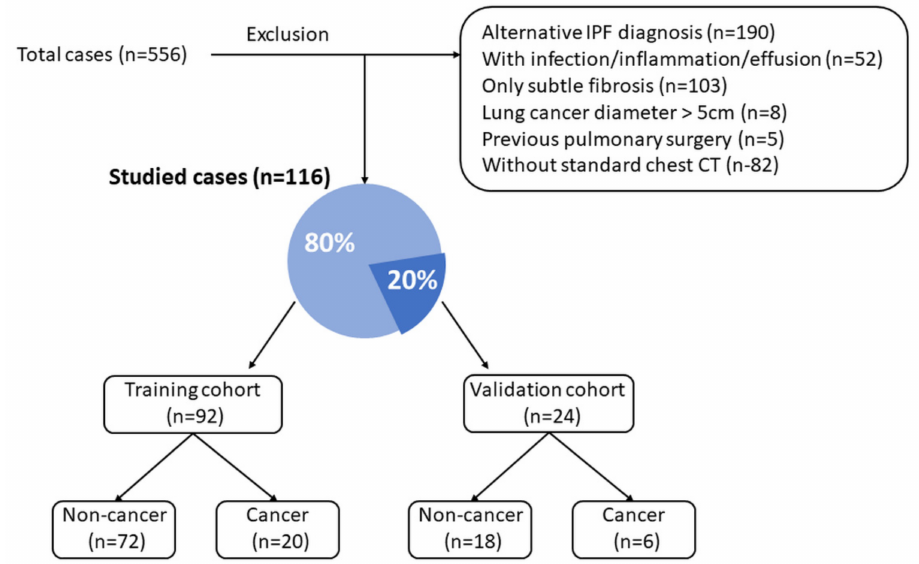
Figure 2. Patient selection flowchart for the training and validation cohorts.